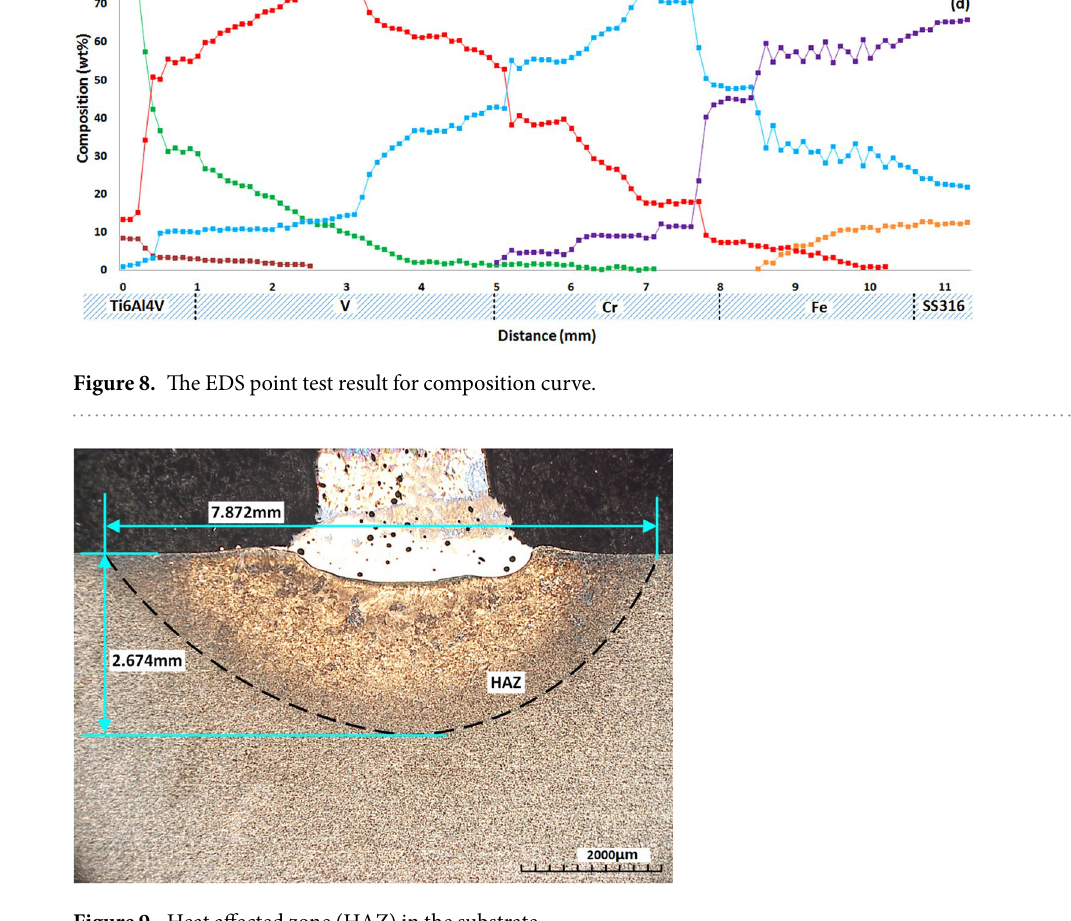
Marangoni convection improves the mass transfer and furthermore improves the diffusion in the multi-metallic structure. Figure 9 depicted the heat affected zone (HAZ) in the Ti6Al4V substrate, whose depth was 2.674 mm and the width of HAZ was 7.872 mm. To observe the microstructure, SEM tests were done on four sample sites which were selected along the route. The four sites positions were determined by the maximum weight percentage of Ti, V, Cr, Fe, which were indicated with signs (a), (b), (c), and (d) in the Fig. 8. Figure 10 shows the microscopic images of microstructure at the four sample sites. Figure 10(a) depicts the microstructure close to the Ti6Al4V substrate, where Ti concentration is highest. It is clear to observe the interface between substrate and V layer. On the below side of interface, the Ti6Al4V region exhibits an elongated lamellar-type microstructure. This is caused by the high cooling rate during laser 3D print- ing process and undergoes rapid solidification. Closer to the interface, thinner and smaller of the microstructure is. From the interface to the Ti6Al4V, it is clear to find the grain’s epitaxial growth in solidification. On the above side of interface, close to V region, some pores are observed which formed in the laser 3D printing process. Figure 10(b) depicts the microstructure with maximum V concentration, which exhibits an equiaxed microstruc- ture. Due to the high cooling rate in rapid solidification, the equiaxed microstructure is elongated approximately along the cooling direction. In the process of laser 3D printing, the powder was carried by argon gas flow then sprayed out into melt pool through powder feeder nozzle. Some gas was dissolved and entrapped in the melt pool, but may not have sufficient time to escape from the melt pool due to rapid solidification in the laser 3D printing. It can be noticed that some spherical pores were observed in V layer. Figure 10(c) depicts the microstructure in the region with highest Cr concentration, which exhibits an equiaxed-type microstructure in this region. Gas porosity is again found in the Cr-rich layer. Figure 10(d) depicts the microstructure where Fe concentration is highest. In this region the microstructure exhibits classic ferrite and austenite grain. High cooling rate in rapid solidification caused the columnar and elongated lamellar-type microstructure. XRD analysis. To identify the formed phase in the sample, XRD test was performed on the surface of sample cut from a central cross section of the printed part. Four sites with the maximum weight percentage of Ti, V, Cr,